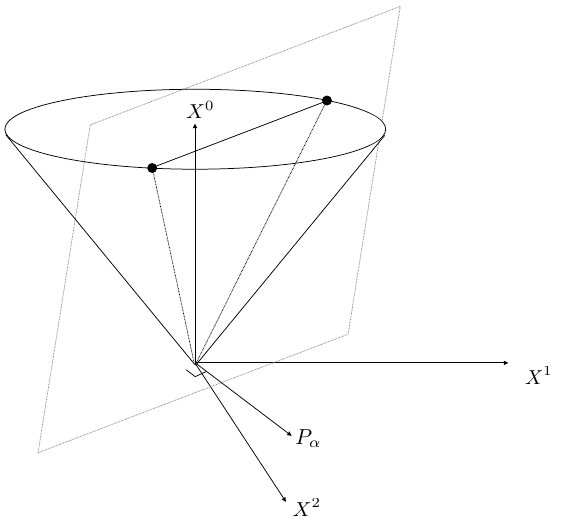
Figure 1 . Null cone in the 3-dimensional embedding space and its intersection with a 2-hyperplane resulting in a spherical 0-defect (i.e. pair of points, denoted by solid dots). The orthogonal vectors P (cid:11) parametrize the hyperplane and hence the